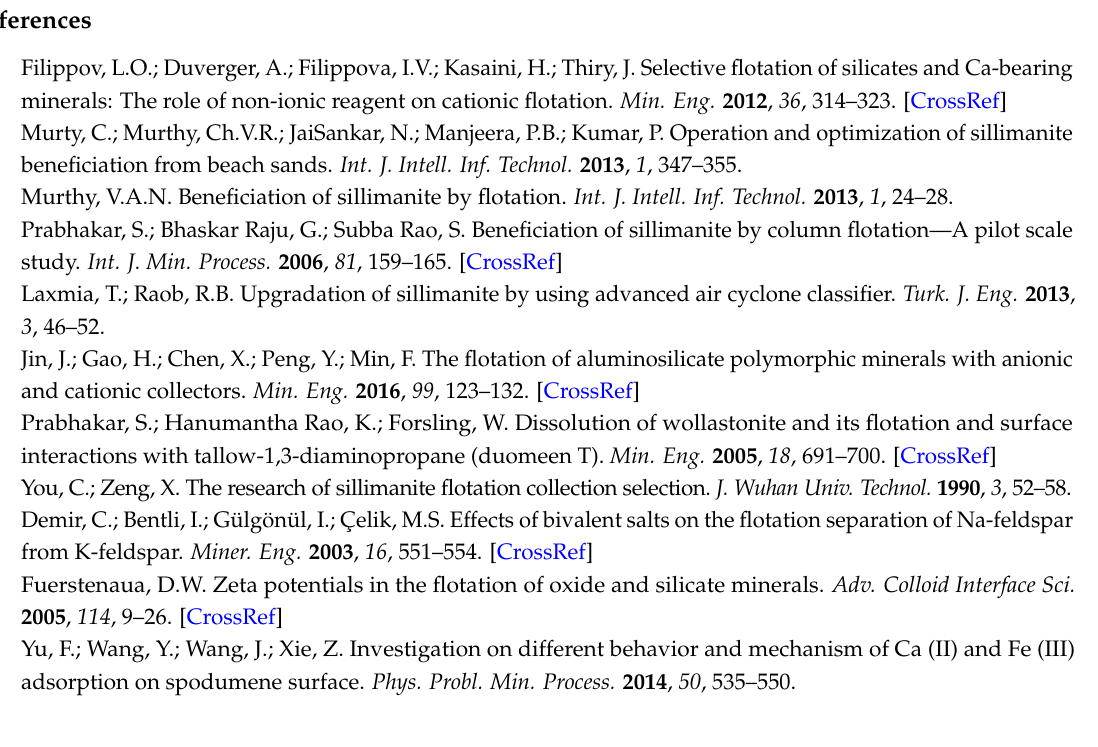
(CN) on the sillimanite (010) surface (atom color: green = Ca, white = H, gray = C, blue =